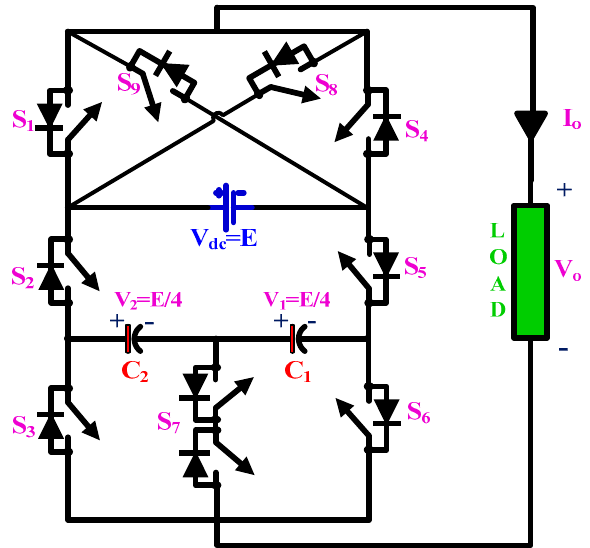
Figure 4. The Modified PEC9 FT MLI Topology. With this modification, there is an increase in the number of redundant switching states. There is one output voltage level produced by each switching state in the Modified PEC9 FT MLI topology, and when all such levels are combined a nine-level periodic voltage is achieved at the output. Table 3 shows all the switching states of PEC9FT-MLI, along with the outputs. Table 3 shows that if there is an open-switch fault in any of the switches S 2 , S 3 , S 5 , S 6 and S 7 , there is still conversion of power from source to load; however, with reduced output voltage levels of seven, five or three, according to the switch location. However, if the open-switch fault occurs in switches S 1 or S 4 or any other switch pair, the post-fault output has the same magnitude and levels as it had in the pre-fault condition. This certainly improves the reliability when critical loads are